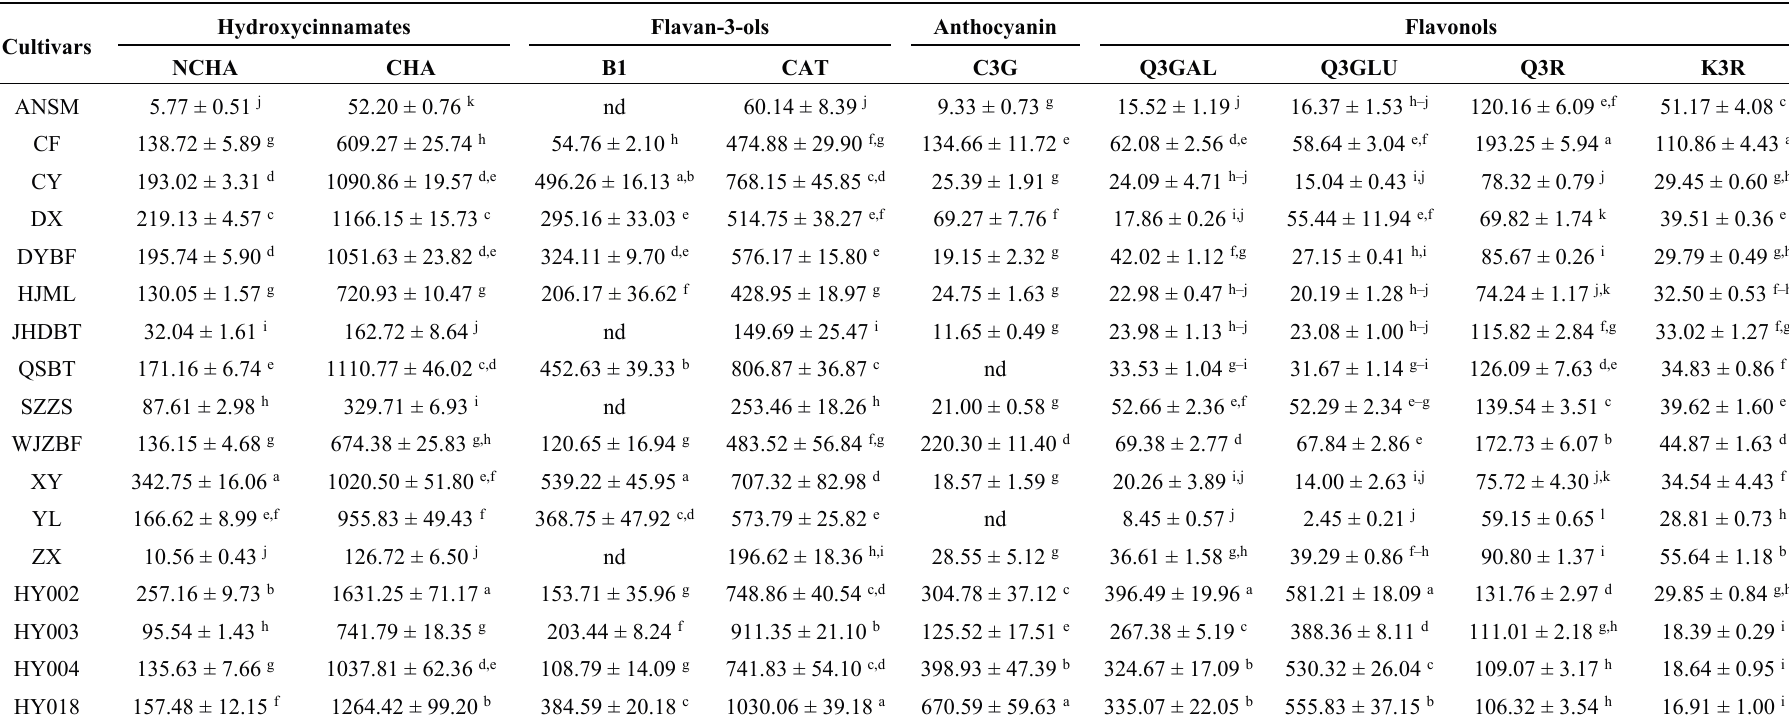
Table 3. Contents of nine phenolic compounds (mg/kg DW) in the peel of 17 P. persica